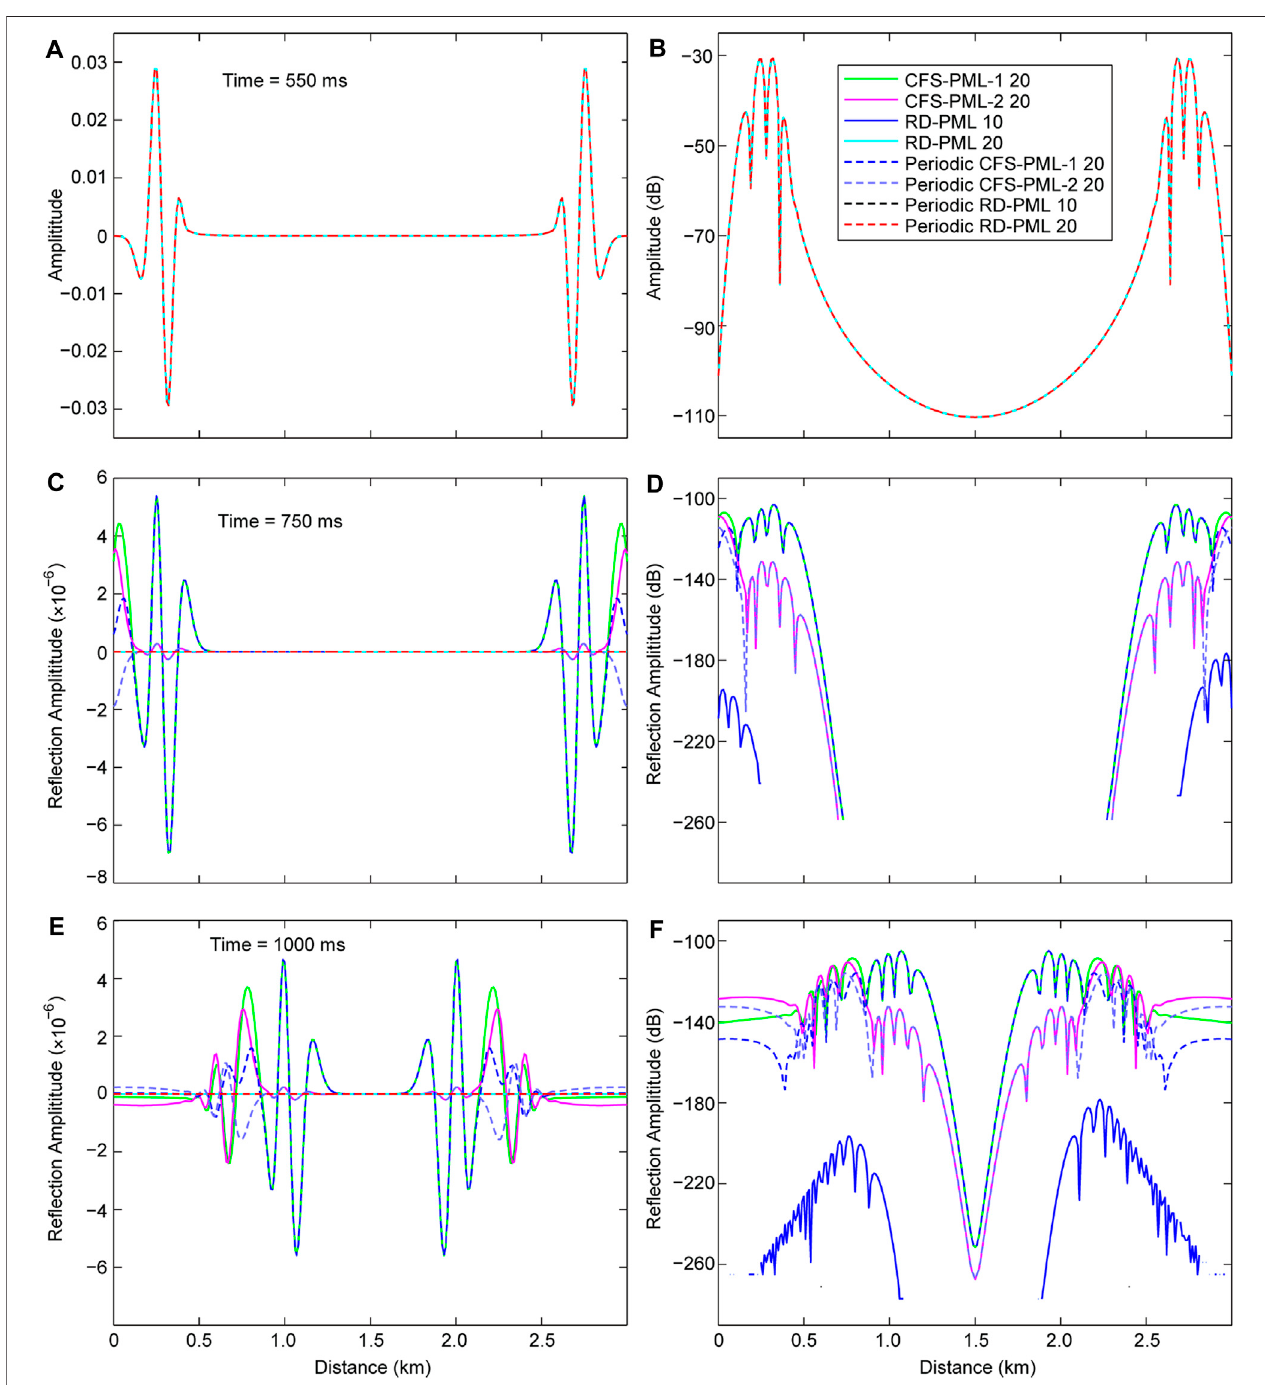
FIGURE 6 | Waveforms along the horizontal dashed line in Figure 4 and Figure 5 at different time. (A) , (C) , and (E) are the waveforms obtained at 550, 750, and 1,000 ms, respectively. (B) , (D) , and (F) are the logarithmic display of waveforms in (A) . (C) , and (E) , respectively.